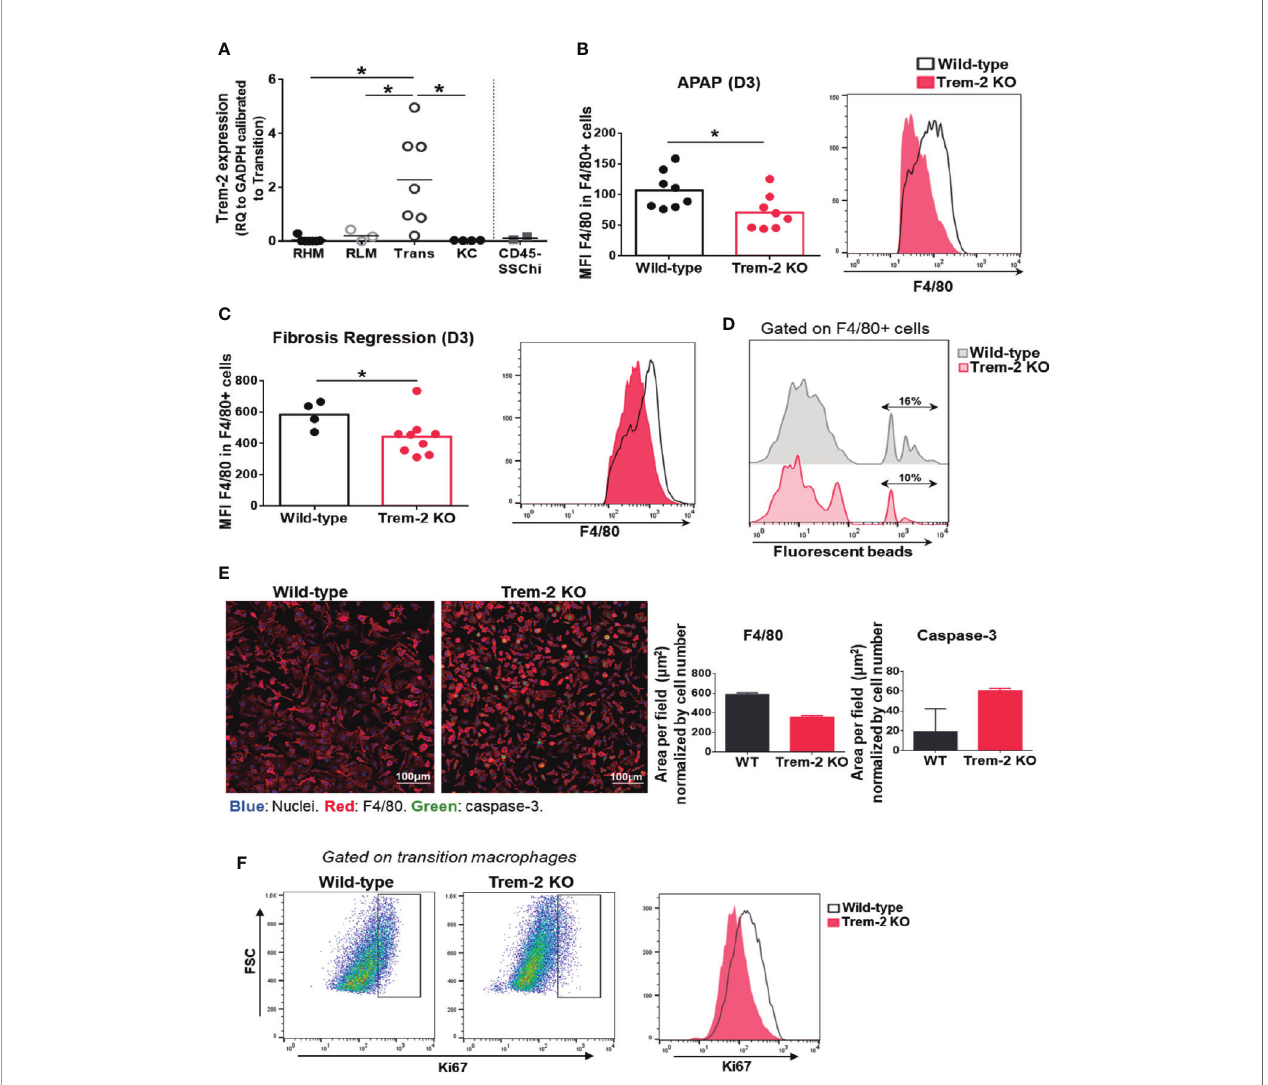
FIGURE 4 | Trem-2 is implicated in acquisition of liver transition macrophages phenotype. Trem-2 gene expression was evaluated by qPCR in sort-puri fi ed macrophage populations and in non-hematopoietic cell population, CD45neg SSChi in wild-type mice and represented as fold change to transition macrophages (A) . F4/80 mean fl uorescence intensity (MFI) among F4/80int/high non-parenchymal cells from wild-type and Trem-2 KO mice at APAP-D3 (B) and fi brosis regression-D3 (C) . Percent of F4/80int/high non-parenchymal cells containing fl uorescent beads in wild-type and Trem-2 KO at APAP-D3 1 h after i.v. injection of 50x106 2 m m Yellow-Green fl uorescent microspheres (D) . Immuno fl uorescence of sort-puri fi ed APAP-D3 transition macrophages from wild-type and Trem-2 KO mice after 3 days of culture (Nuclei (blue), F4/80 (red), caspase-3 (green). Merged images are shown and quanti fi cation of F4/80 and caspase-3 stained area normalized by nuclei is plotted (E) . Representative fl ow cytometry plots showing Ki67 staining in APAP-D3 transition macrophages from wild-type and Trem-2 KO mice (F) . Statistics: One-way ANOVA and Tukey ’ s correction in (A) Mann Whitney test in (B , C) *,